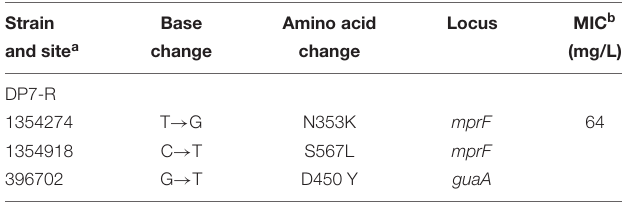
a Location of mutations in the S. aureus strain ATCC 25923 sequence. b The MICs with the highest frequencies for each species. Values are averages from three independent experiments performed in